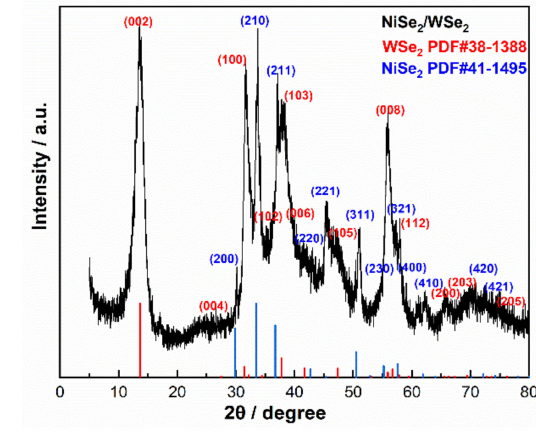
Figure 3. XRD of NiSe 2 / WSe 2 .